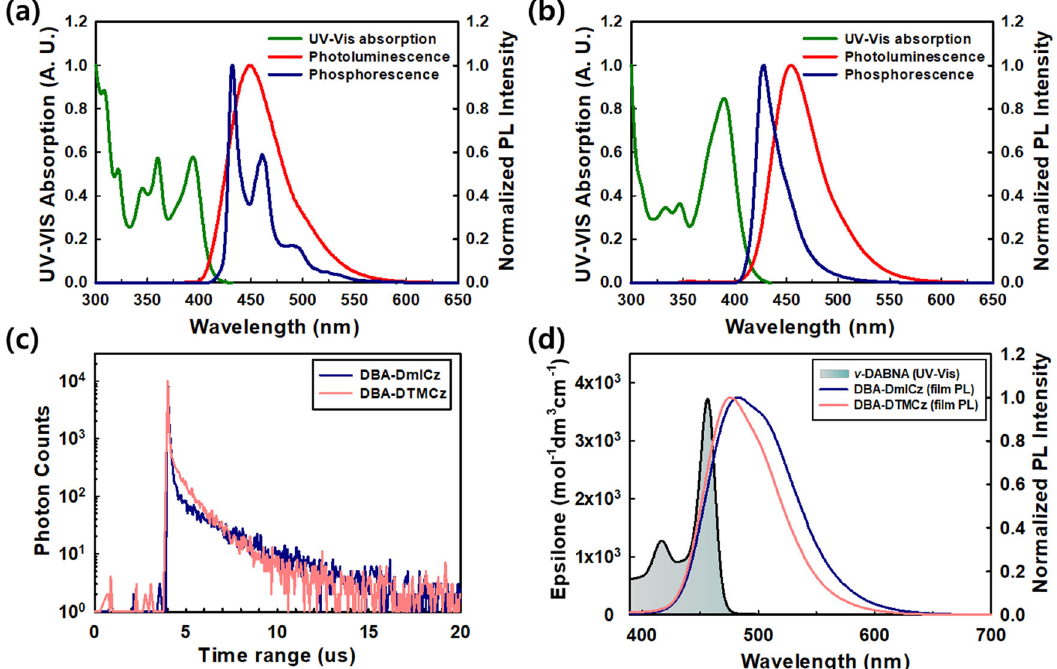
Fig.3|Thephotophysicalmeasurements. ThenormalizedUV-Visabsorption,PL, and phosphorescence spectra of a DBA-DmICz and b DBA-DTMCz in toluene solution (10 – 5 M). The UV-Vis absorption and PL spectra were measured in 300K, and the phosphorescence spectra were measured in 77K with 30ms of